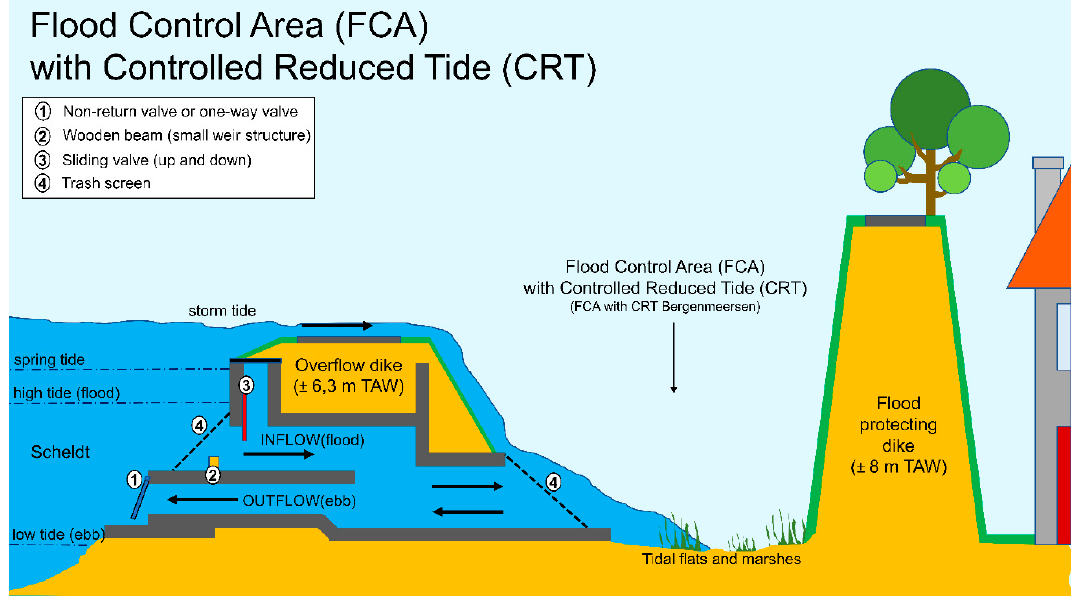
Figure 2. Cross section of flood control area (FCA) with controlled reduced tide (CRT) Bergenmeersen also showing the internal structure of the in- and outflow culverts. TAW is the Belgian vertical reference plane where 0 m TAW corresponds to low water level at sea.